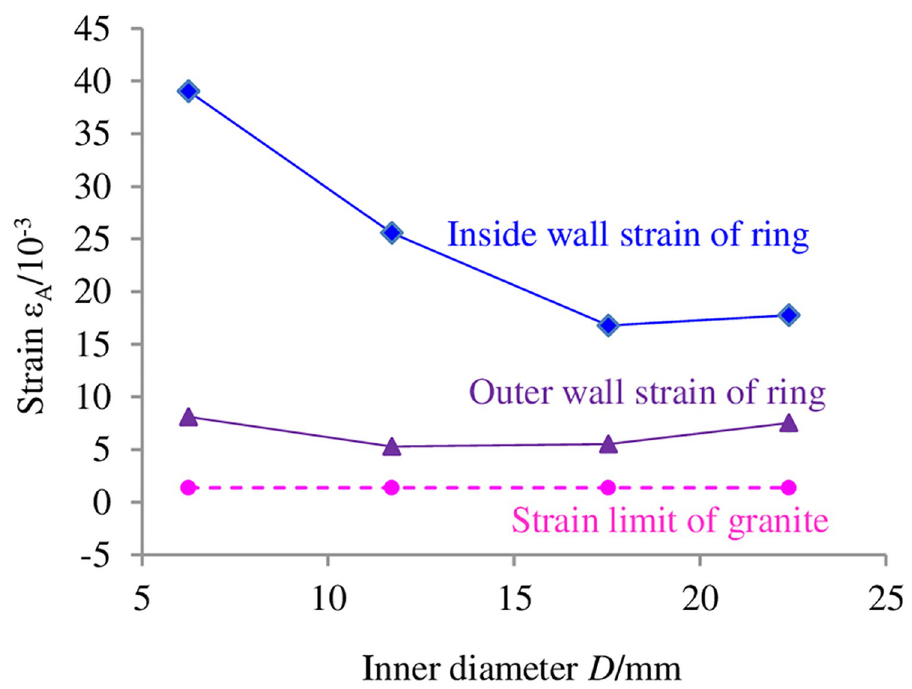
Fig 12. Verification result of the failure criterion test of circular